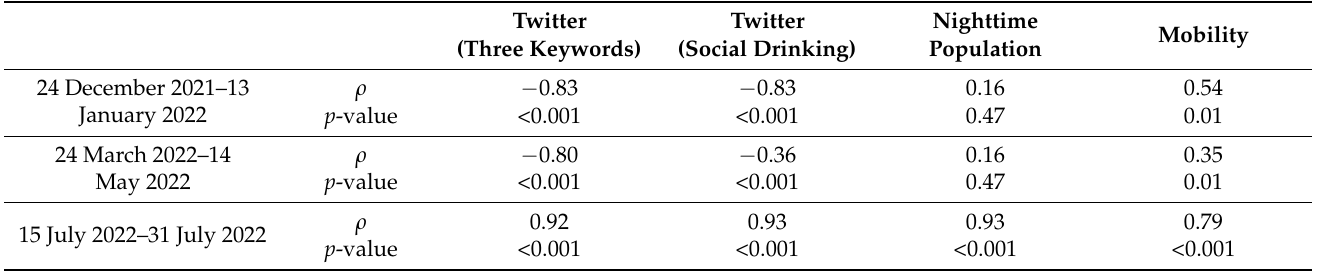
Figure 3. Correlation between 7-day average daily drop from estimated population VE and ( a ) Twitter, ( b ) mobility at transit stations, ( c ) nighttime population before and after the quasi-state of emergency. The period of blue plots, orange plots, and gray plots are from 24 December 2021 to 13 January 2022, from 24 March 2022 to 14 May 2022, and form 15 July 2022 to 31 July 2022, respectively. Table 2. Spearman’s rank correlation between 7-day average daily drop from estimated population effectiveness of vaccination and different parameters of human